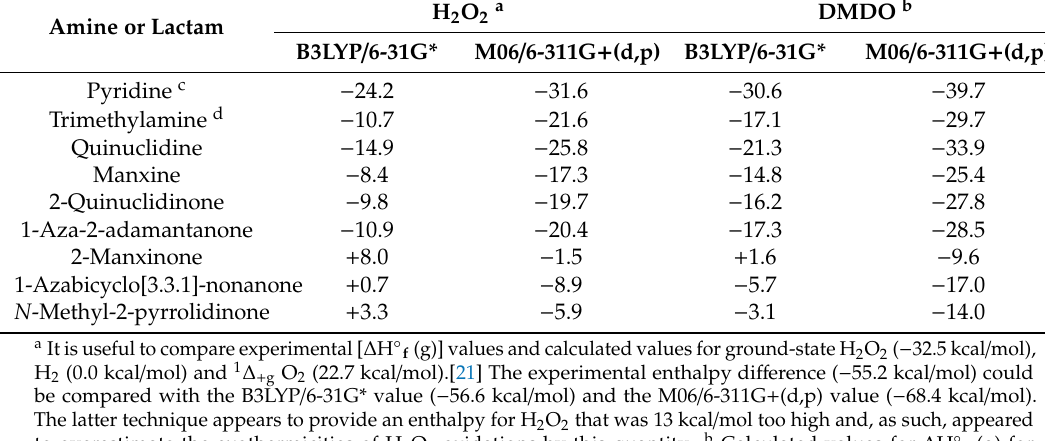
Table 6. Calculated enthalpies (kcal / mol) of oxidation of selected amines or lactams by hydrogen peroxide (H 2 O 2 → H 2 O) or dimethyldioxirane (DMDO → Acetone). H 2 O 2 Amine or Lactam